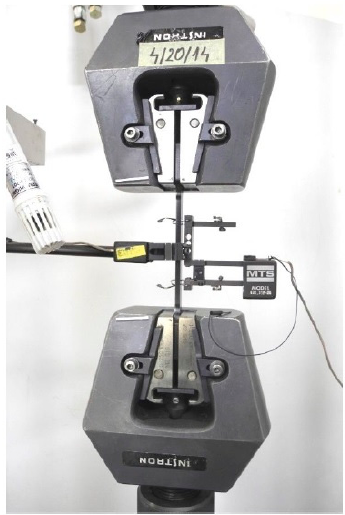
Figure 10. View of the sample fixed in the strength machine before the test.